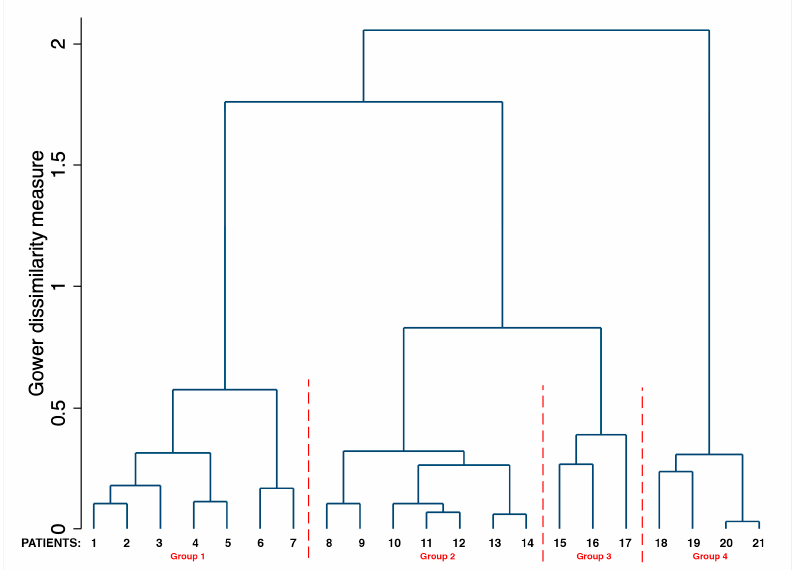
Figure 2. Dendrogram resulting from cluster analysis testing for the distribution and aggregation of immune response variables in hospitalized COVID-19 patients.